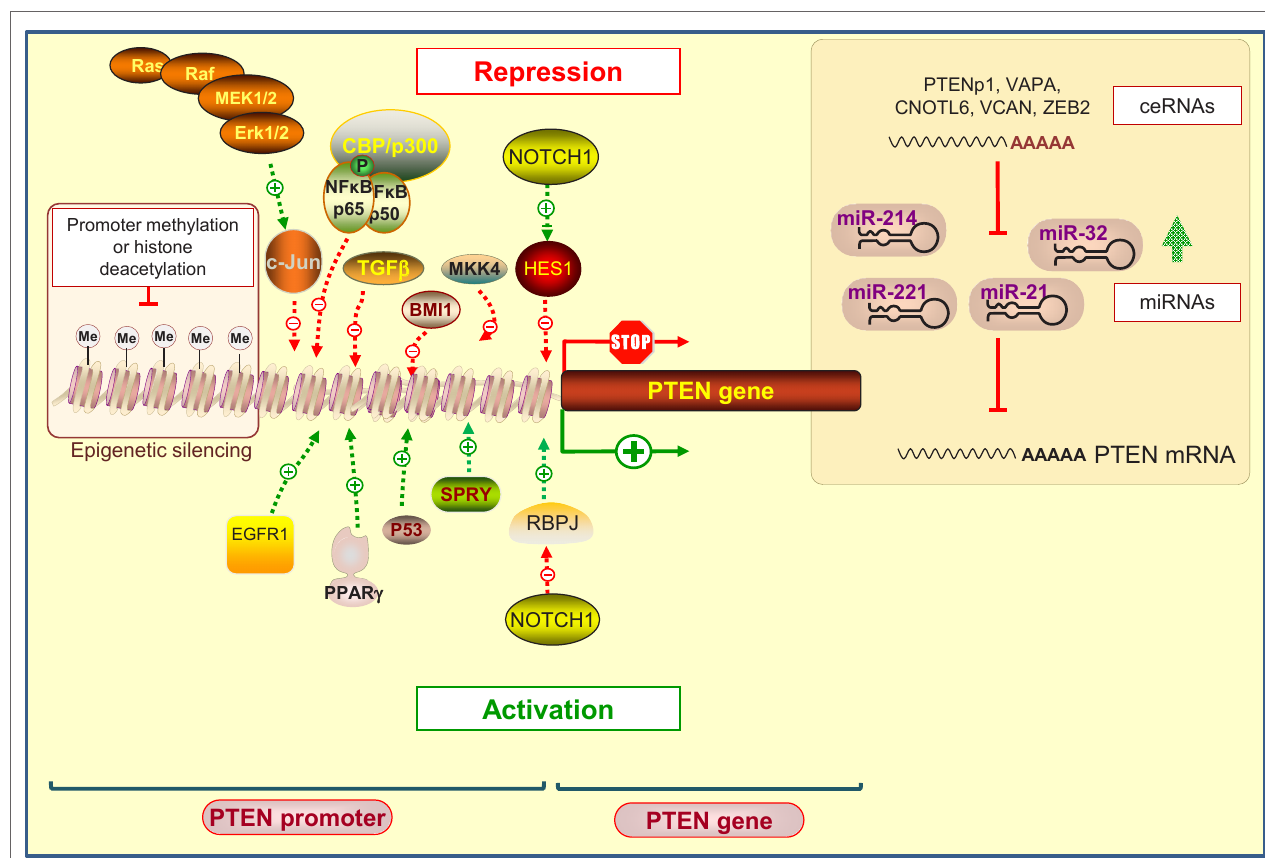
been shown that NOTCH signaling could be either a negative or positive regulator of PTEN transcription targeting the transcription factor hairy and enhancer of split1 (HES1) or the recombining binding protein suppressor of hairless (RBPJ, also known as CBF-1), respectively. Epigenetic silencing by the gene promoter methylation and histone modifications may also negatively control PTEN expression. At the post-transcriptional level, a variety of miRNAs have been identified to repress PTEN mRNA translation. An additional level exists, involving endogenous non-coding transcripts that have regulatory functions by quenching miRNAs, such as PTENpg1 and